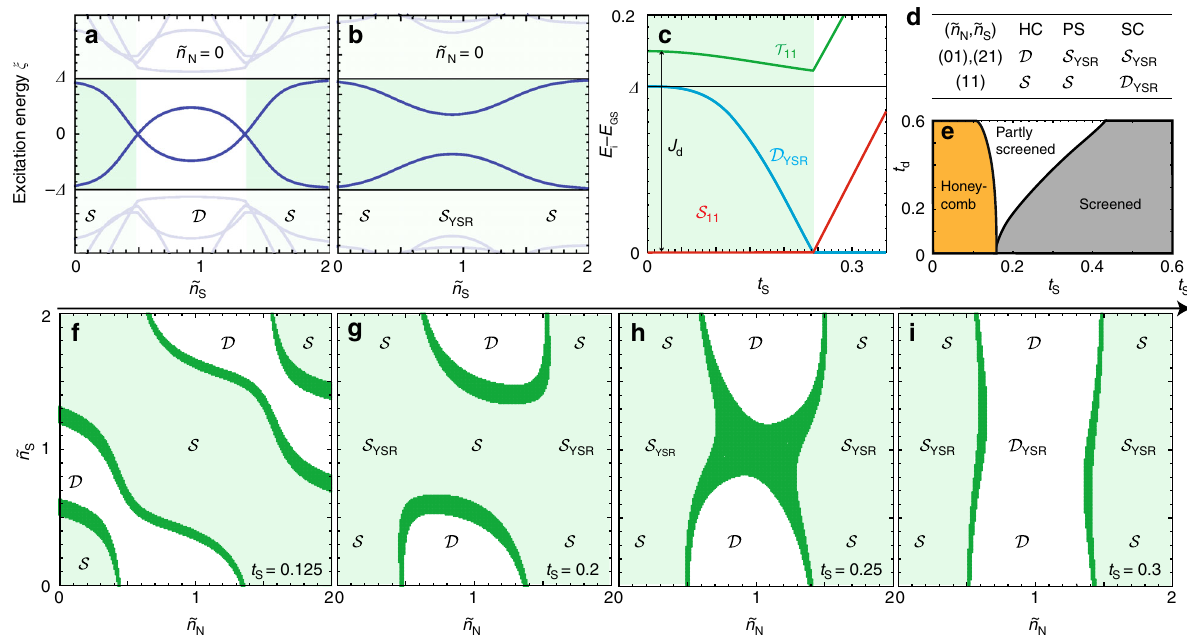
¼ 0 (single dot case). For weak and strong coupling to of QD S for ~ n Fig. 2 YSR phase diagrams. a , b Two distinct YSR sub-gap spectra vs. occupation ~ n S N the superconductor, the doublet D ( a ) and YSR singlet S ( b ) is the ground state for odd occupancy, respectively. c ZBW model calculation in the (11) YSR charge state, with singlet S 11 and triplet T 11 separated by the interdot exchange energy J d . The triplet is YSR-screened and gives rise to a sub-gap YSR doublet D , which becomes the ground state (GS) for large enough t S . d , e Double-dot YSR phase diagram hosting three regimes ( e ): honeycomb (HC), YSR partly screened (PS) and screened (SC). The ground states in the (01) and (21), and the (11) charge regions for the three regimes are shown in d . f – i Stability diagrams for increasing t S show the transitions between honeycomb ( f ), partly screened ( g ) and screened ( i ) regimes. The ground states are explicitly stated for the YSR-screened states, while trivial singlet and doublet states may cover several charge sectors. A singlet-doublet energy splitting less than 0.015 meV (i.e. close to degenerate) de fi nes the dark green region. For h S 11 and D are almost degenerate corresponding to a transition in (11) YSR which is unique to the DQD-S system. Parameters (in meV) used in d – i are extracted from experimental data (see Supplementary Note 2, Device A): U N = 2.5, U S = 0.8, U d = 0.1, t d = 0.27, t S = 0.22, Δ = 0.14